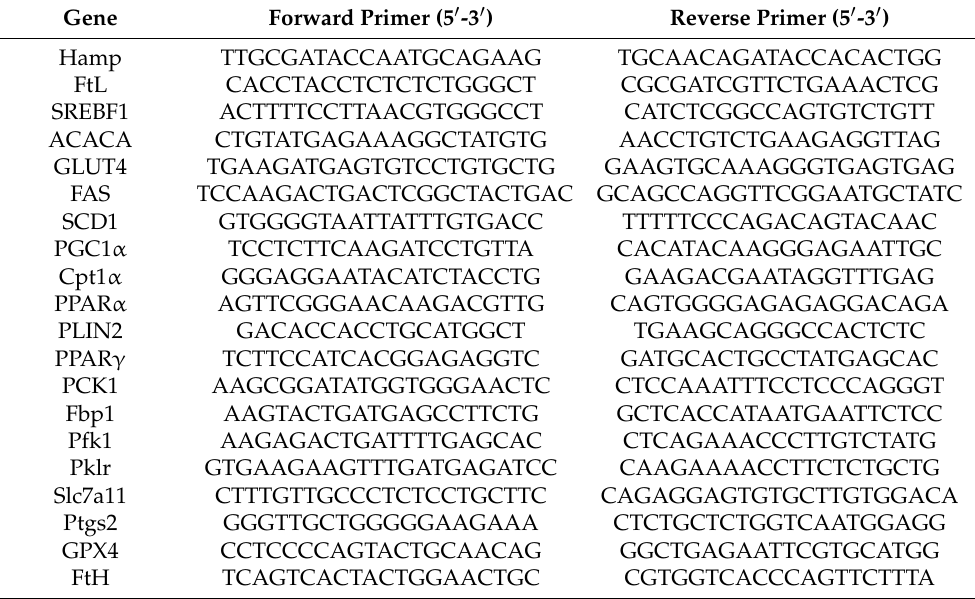
Table 1. Primer sequences applied in real-time quantitative